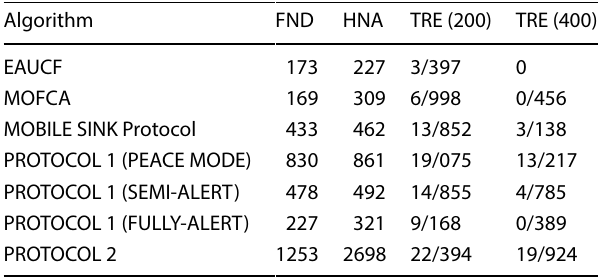
Table 2 Simulation results in scenario 1